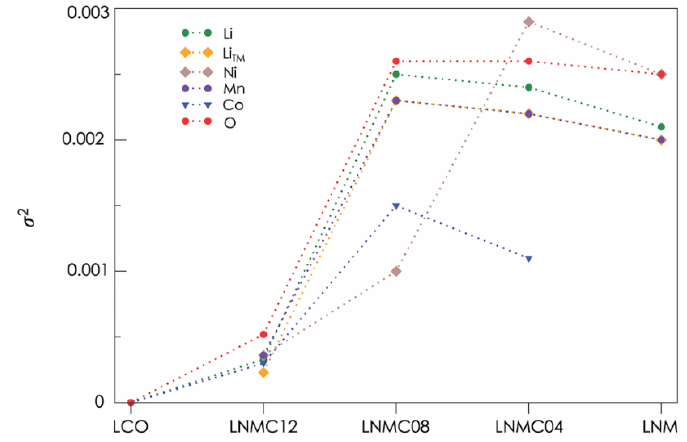
Figure 2. Mean (a-dimensional) displacements factors σ 2 calculated on fractional coordinates for each atomic species in LNMC12, LNMC08, LNMC04, and LNM supercells.